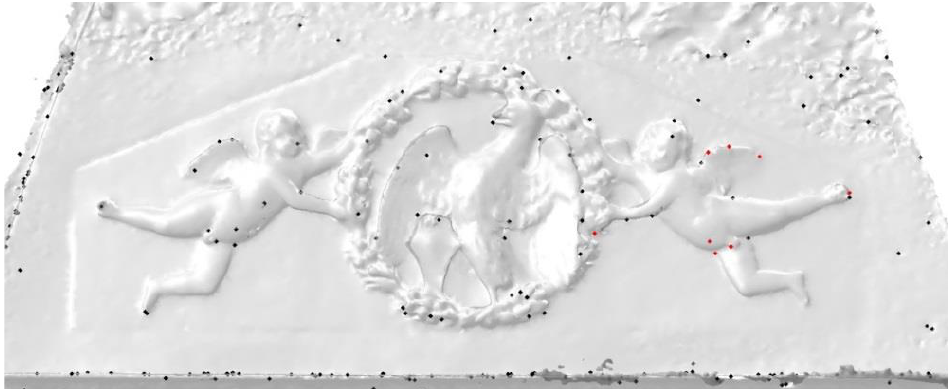
Figure 7. The cropped view of the 3D mesh with extracted matching vertices using the quantization level of 14 × 42 × 20 and tolerance 1/6: all extracted quantized vertices in this area (black markers), and matched vertices (red markers).